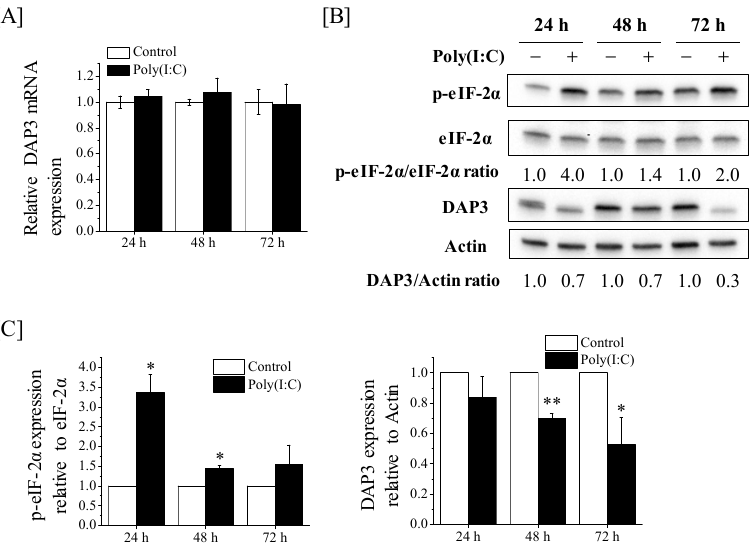
Figure 6. Effects of Poly(I:C) on the DAP3 mRNA expression and p-eIF-2 α protein expression in A549 cells. ( A ) A549 cells were cultured with Poly(I:C) for 24–72 h and harvested for qRT-PCR. Data are presented as mean ± SD of three independent experiments. ( B , C ) A549 cells treated with Poly(I:C) were cultured for 24–72 h and harvested for western blotting. ( B ) Representative images of immunoblots are shown. Actin was used as the loading control. ( C ) The relative values of phosphorylated eukaryotic initiation factor-2 α (p-eIF-2 α )/eIF-2 α and DAP3/actin ratio are presented as mean ± SD of three independent experiments. One sample t- test was performed using the GraphPad QuickCalcs. * p < 0.05, ** p < 0.01 versus control.